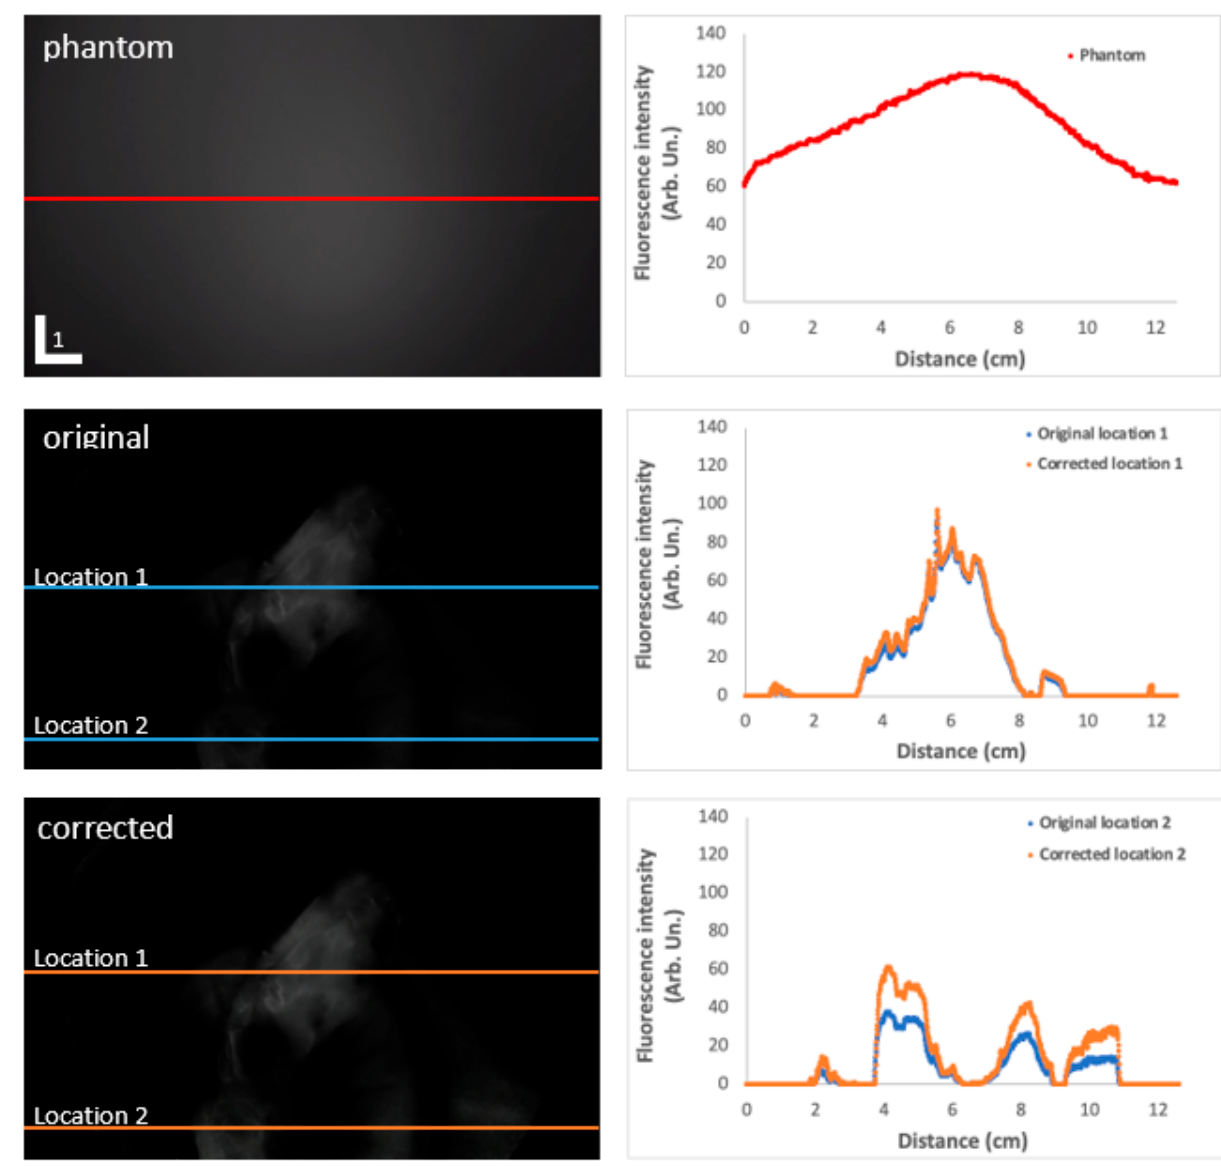
Figure 5. Top left image showing the phantom using the Stryker 1688 camera. The red line indicates the position of the adjacent graph with a fluorescent intensity distribution. The middle and lowest images both show the fluorescent image of a segment of colon during a transanal total mesorectal excision before and after correction. The blue and orange lines indicate the location on the intensity distributions plotted in the two adjacent graphs for the central and peripheral part of the image both before (blue) and after (orange) correction. The corrected result is therefore a more realistic representation of the fluorescence distribution in the tissue.